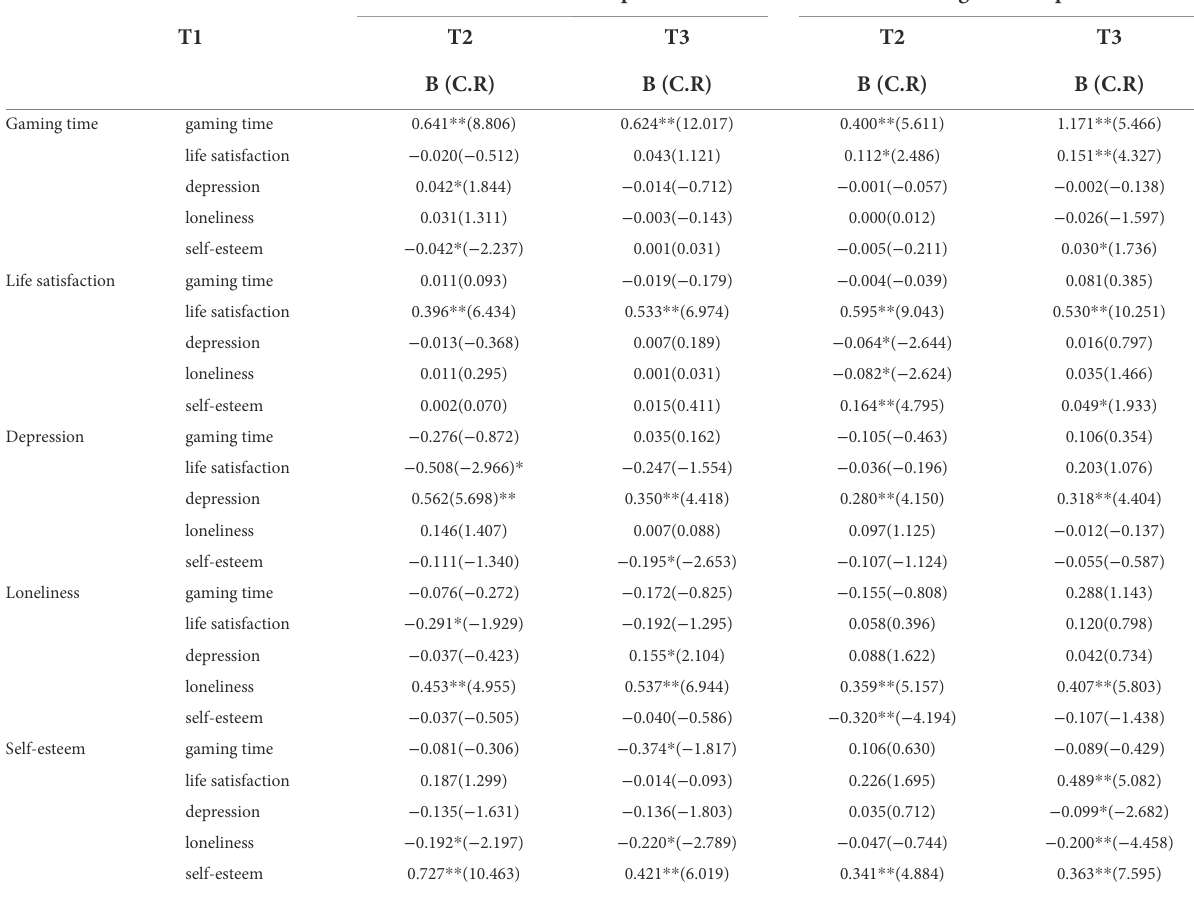
TABLE 4 Results of hypotheses testing: Social capital lower group vs. higher